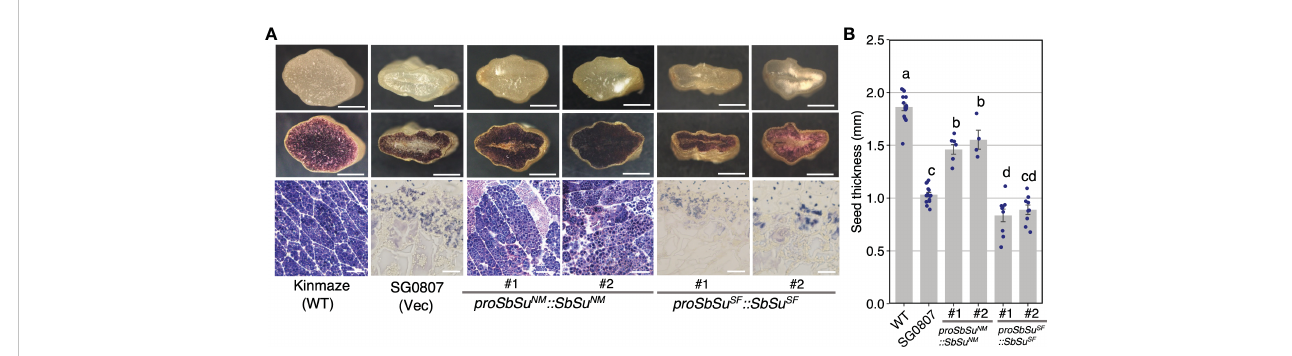
FIGURE 3 Complementation of the rice su1 mutant with SbSu . A DNA fragment containing a 2 kb promoter fragment followed by the SbSu coding region (NM; Nakei MS-3B, SF; SUGARY FETERITA) was introduced into the rice su1 mutant, SG0807. The SG0807 mutant (vec) and Kinmaze (wild-type) plants transformed with an empty vector were used as controls. (A) Grain morphologies of wild-type rice (Kinmaze), SG0807, and transgenic seeds. Crossed sections shown in the upper pictures were stained with iodine solution (middle) to observe starch structures (bottom). Scale bars: 1 mm (upper and middle) and 20 m m (bottom). (B) Comparison of seed thickness in wild-type, SG0807, and transgenic lines. For statistical analysis, an ANOVA model was followed using Tukey ’ s HSD test to estimate statistical differences. Different lowercase letters in each plot indicated signi fi cant differences in the post- hoc test ( P < 0.05).